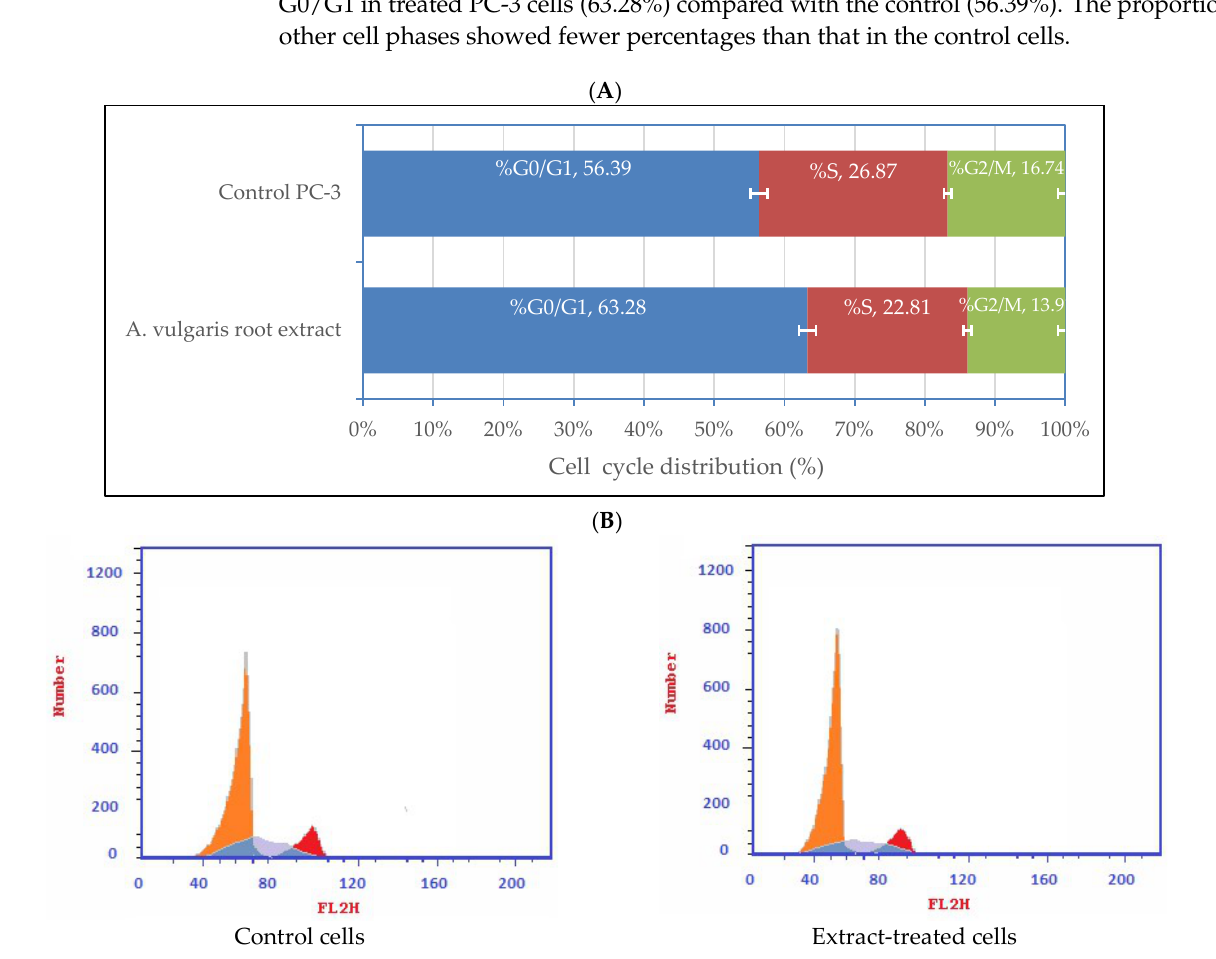
Figure 4. Cell cycle distribution of PC-3 cells treated with A. vulgaris root extract at 88.0 µg/mL: ( A ) quantitative cell cycle distribution percentage illustrated by the bar graph with cell growth arrest@ G1; ( B ) flow cytometry histogram showing DNA content of extract-treated cells. The data presented are the means ( n = 3) ± SD indicated by the horizontal bars.